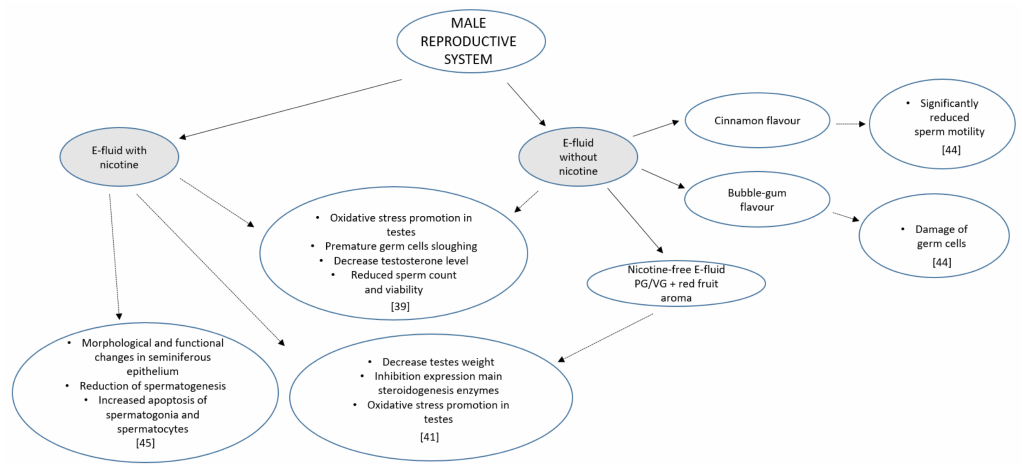
Figure 2. The e ff ect of e-fluid with and without nicotine on male reproductive